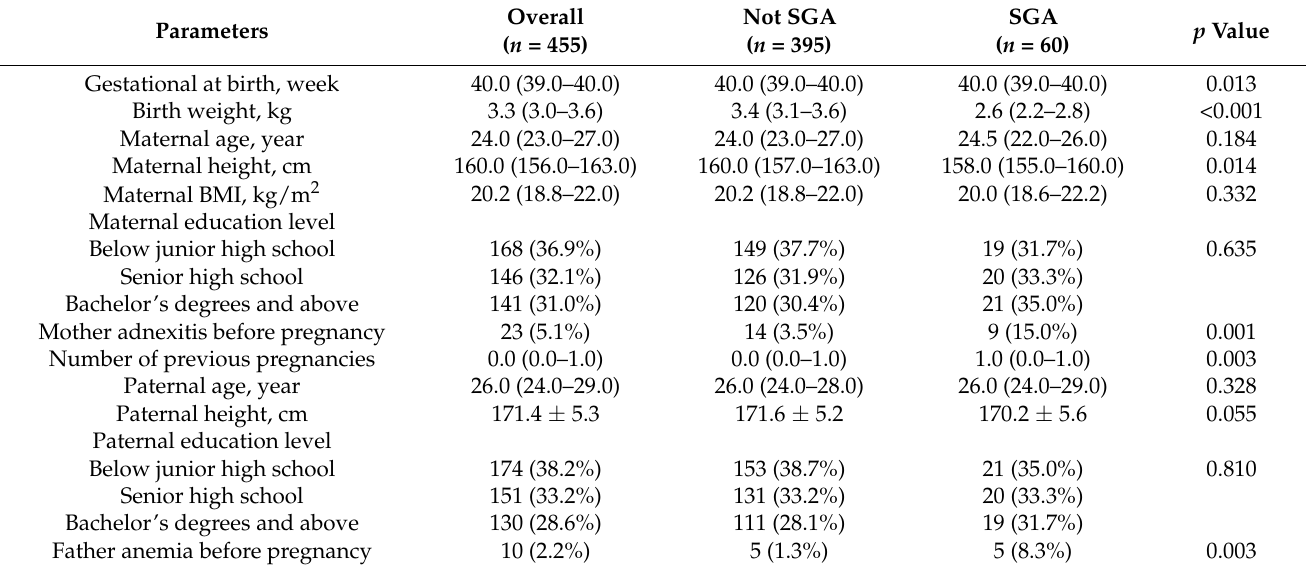
Table 1. Demographic characteristics of the subjects included in